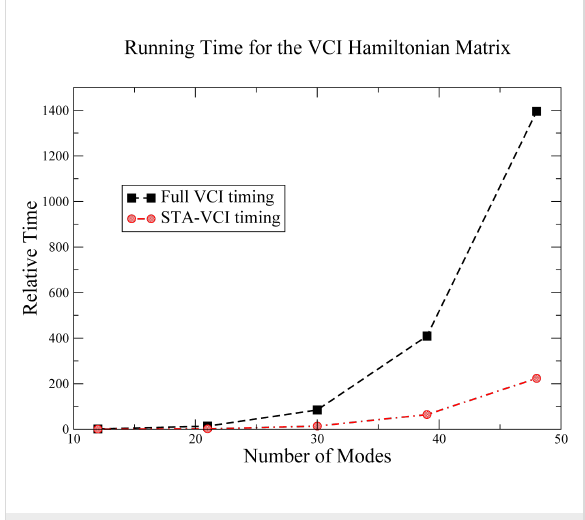
Figure 4: Representative timing for the construction of the Hamil- tonian VCI matrix for a series of aliphatic alcohols (methanol to pentanol), for both standard VCI (Full VCI) and STA–VCI methods. All timings are relative to methanol using the standard VCI